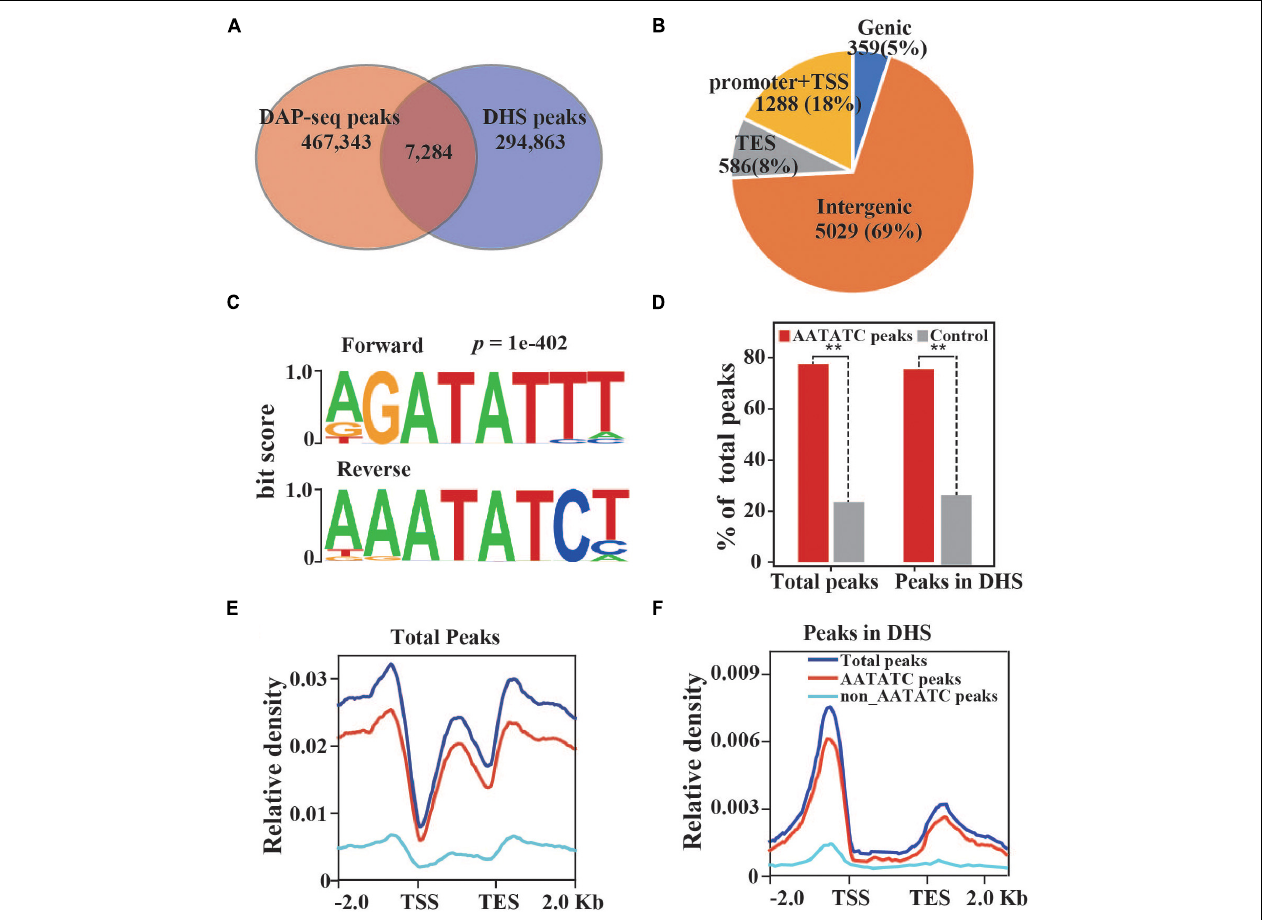
FIGURE 6 | Identification of TaCCA1-7D binding loci with DNA affinity purification and sequencing (DAP-seq). (A) An overlap between DAP-seq peaks and DNase-I hypersensitive sites (DHSs). The overlapped peaks were used for the following analysis. (B) Distribution of filtered DAP-seq peaks in different genomic regions. (C) Enriched DNA binding elements in DAP-seq peaks. (D) AATATC motifs were significantly enriched in DAP-seq peaks. The shuffled genomic regions were used. (E,F) Distribution of DAP-seq peaks (E) and filtered DAP-seq peaks (F) in ± 2 kb of genes. Asterisks indicate significant difference of enriched AATATC peaks between TaCCA1 DAP-seq and control by the Fisher’s exact test (** P <